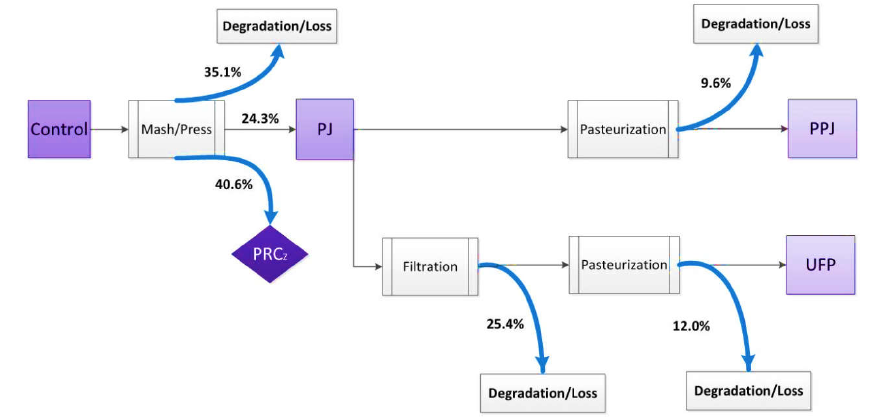
Figure 6. Percent anthocyanidin loss through unfiltered and ultrafiltered rabbiteye blueberry juice processing. PRC = press cake; PJ = pressed not filtered juice; PPJ = pasteurized pressed unfiltered juice; UFP = filtered pasteurized juice. Filtration box specifically refers to ultrafiltration (UF), as described in the M&M.